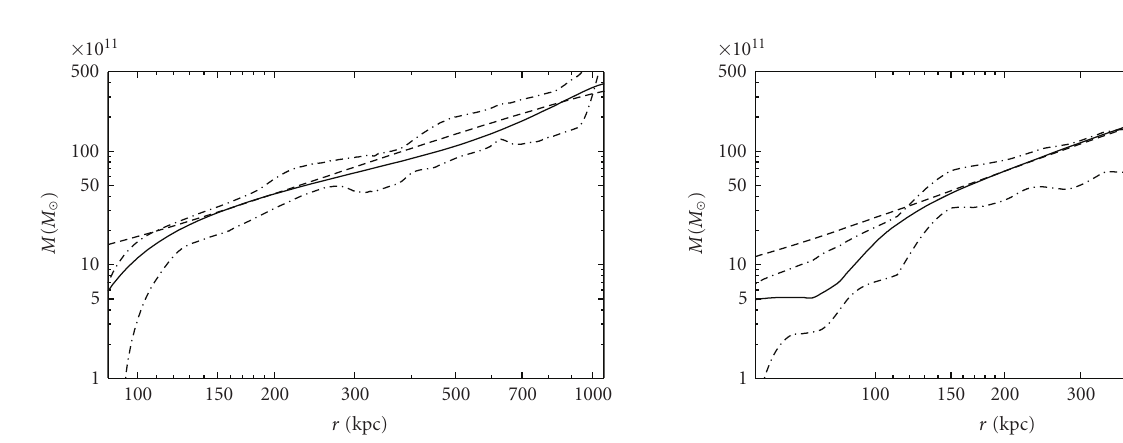
Figure 9: As the above case, for cluster Abell